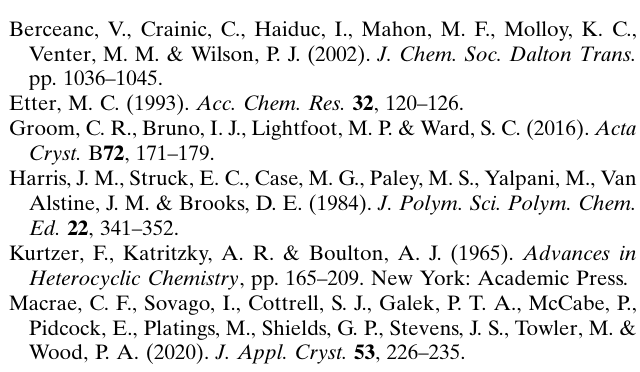
placed in idealized positions (N—H = 0.86, C—H = 0.96– 0.97 A˚ ) and refined as riding on their carrier atoms [ U (C,N) or 1.5 U (C-methyl)]. In (II), all hydrogen atoms 1.2 U eq eq